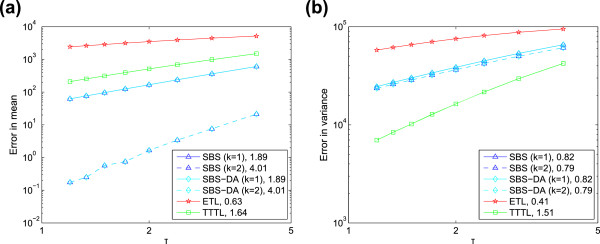
Order of accuracy for linear system. Error versus stepsize for
(a) mean, and (b) variance of the linear system
X→2X, with c=0.2, X(0)=1000,
T=12. The gradients of linear regression lines fitted to the points
are shown in the legend.